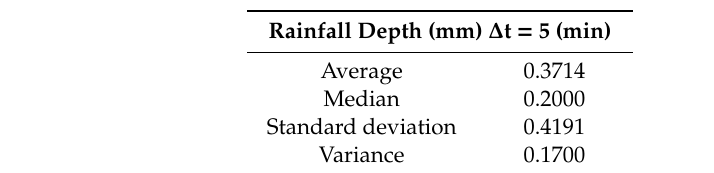
Table 3. Statistical rain events